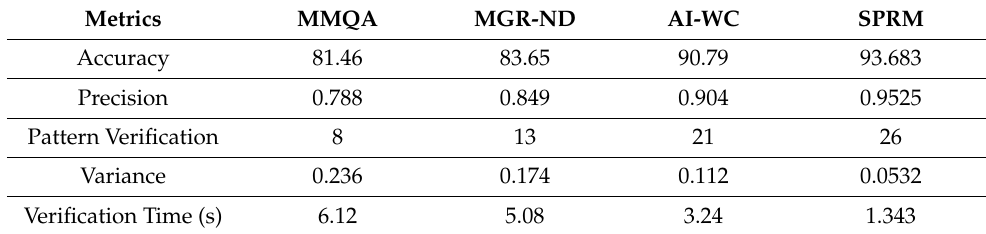
Table 2. Summary of